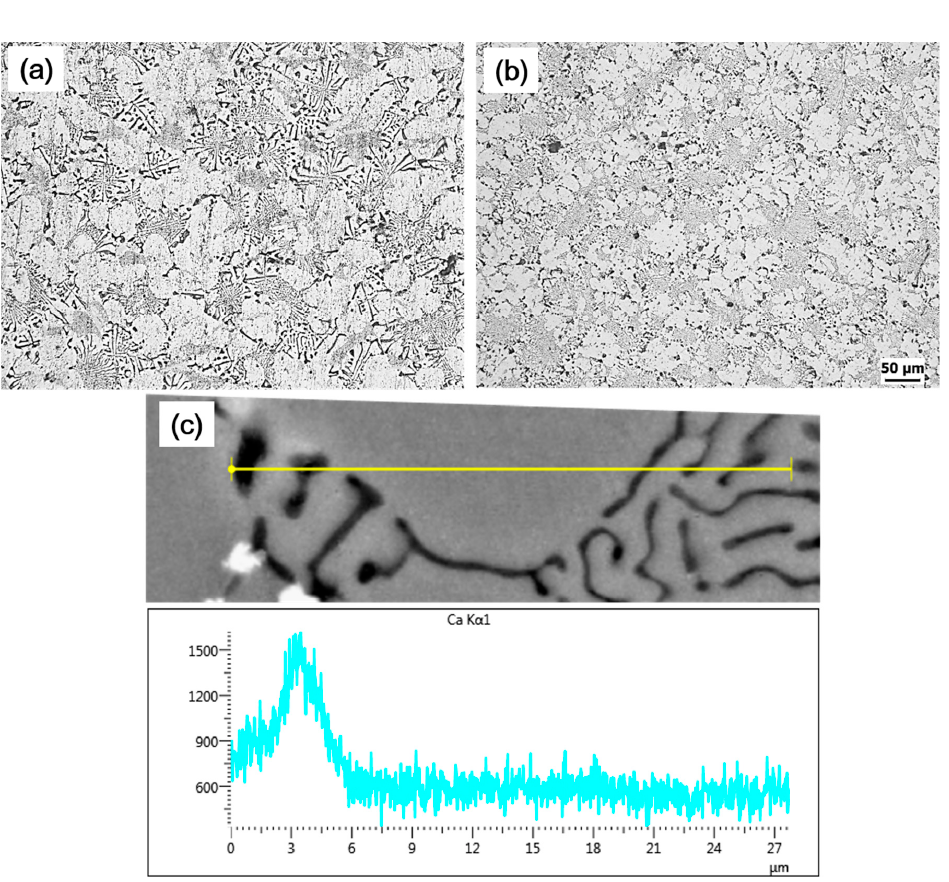
Figure 2. Optical microstructure of ( a ) A1 alloy and ( b ) E1 alloy at relatively 200× magnification representing the relative size of SDAS in examined alloys. ( c ) It shows the SEM–EDS (line scan) analysis result presenting the Ca composition variation across the dendrite and interdendritic region in E1 alloy.